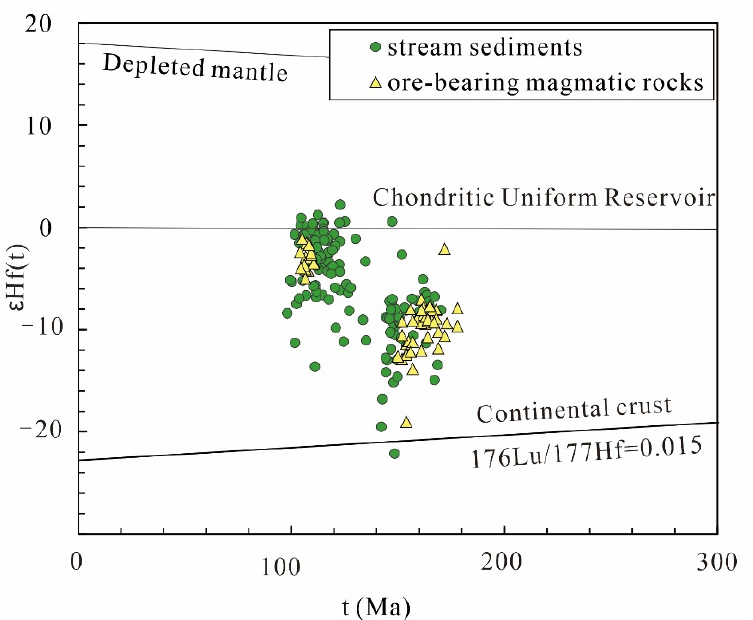
Figure 7. U–Pb ages and ε Hf(t) composition diagram of detrital zircons of stream sediments in the Zijinshan Orefield. Data on magmatic zircons of ore-bearing magmatic rocks in the Zijinshan Copper-Gold Orefield derived from [53–55].